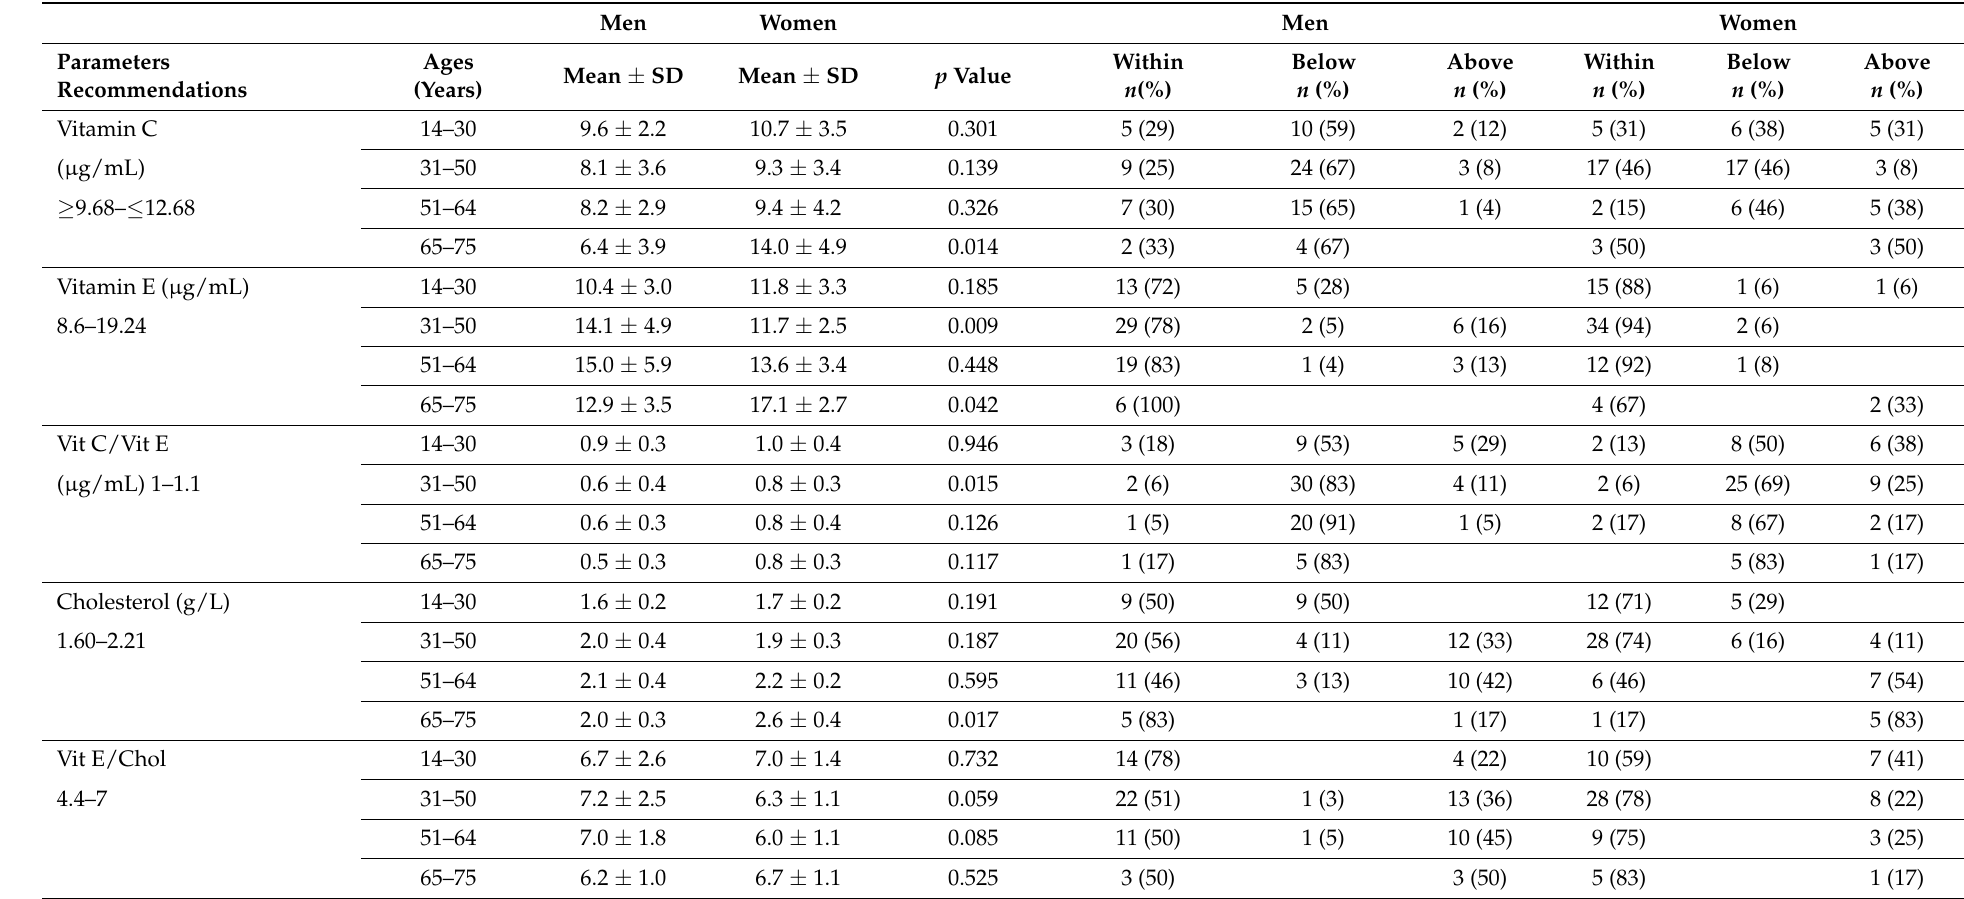
Table 10. Plasma concentrations of vitamins and minerals and their adequacy in 159 patients with FSHD according to age. Men Women Men